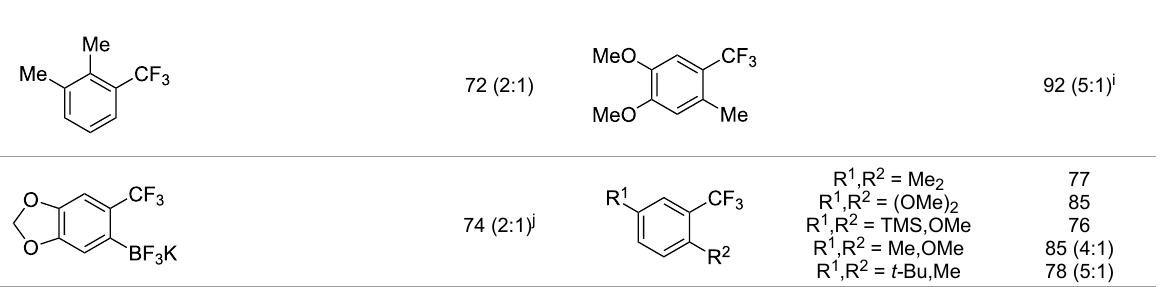
Table 31: Ru-catalyzed photoredox trifluoromethylation of (hetero)arenes with trifluoromethanesulfonyl chloride [105]. (continued)